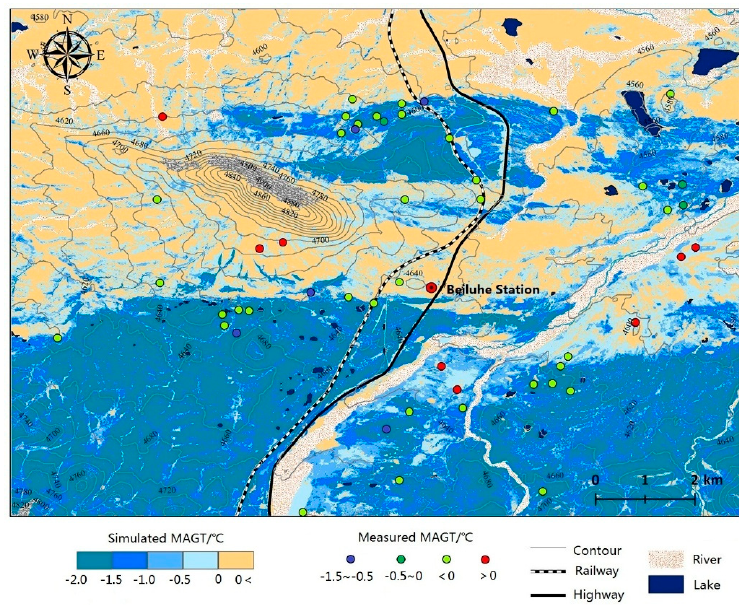
Figure 5. Modeled permafrost thermal condition (MAGT at 10 m depth) for the period of 2006–2015.